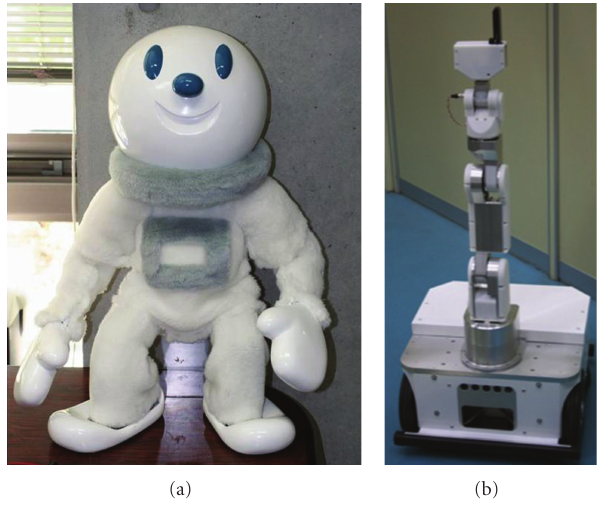
Figure 8: TAIZO (a) and RH-1 (b) robots.